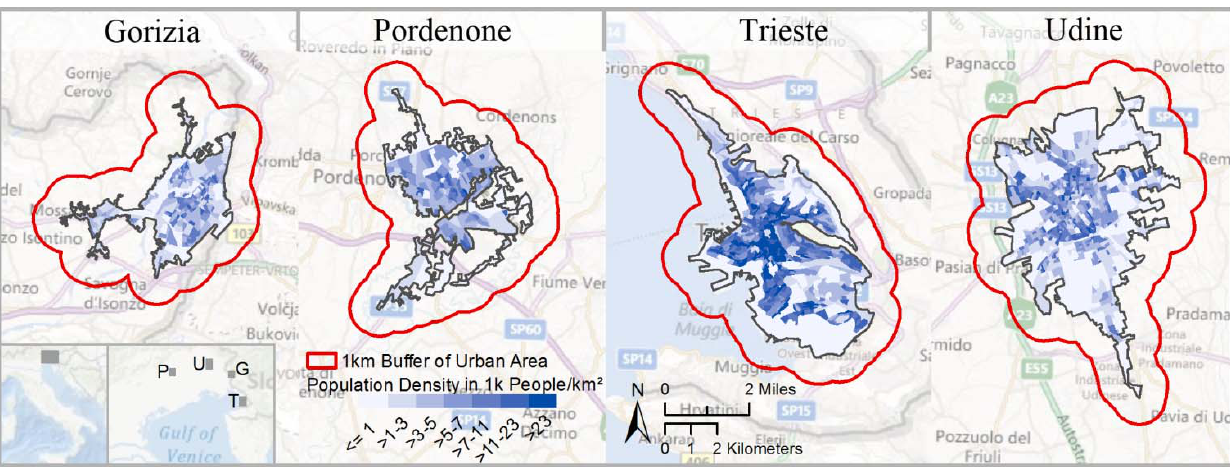
Figure 1. Case study areas: four urban environments in the Friuli Venetia Giulia region including their close